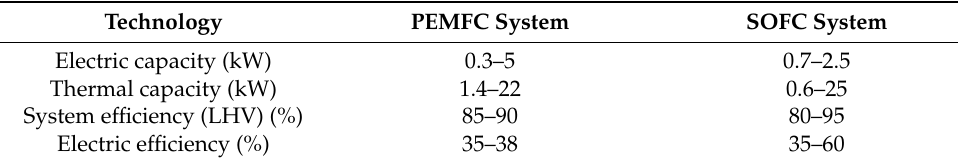
Table 6. PEM and SOFC System